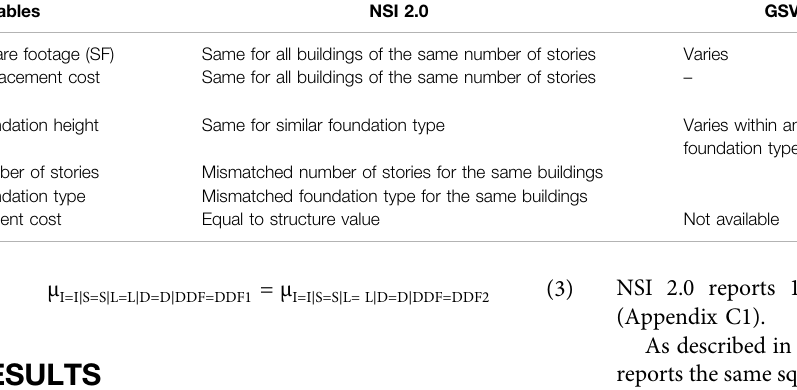
TABLE 5 | Comparison of NSI 2.0, GSV, and JPBI data for the same neighborhood (census block 220510220012004). Variables NSI 2.0 GSV Square footage